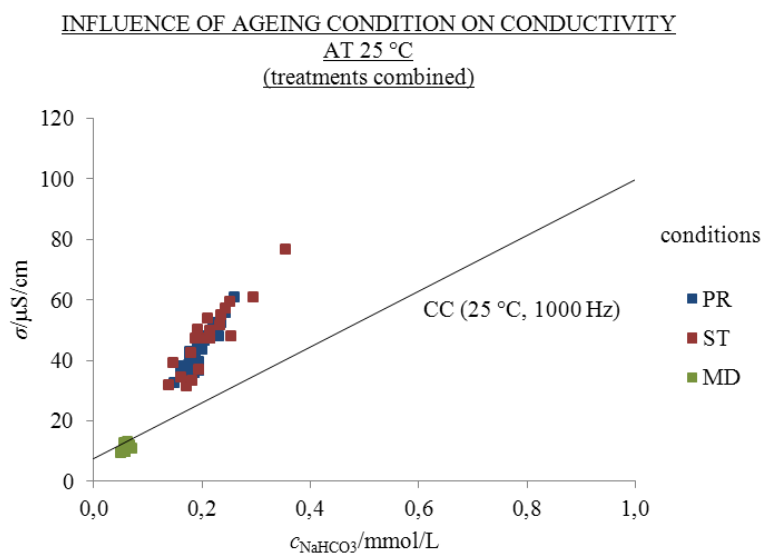
Figure 6. σ at 25 °C and 1000 Hz as a function of c 310 days in 2 mL volume of 2.5 mL flasks under conditions PR (blue), ST (red) and MD (green) aged solutions; points in the graph represent individual measurements; number of replicate solutions, N (/): PR (28), ST (20), MD (20). Treatments are combined; conductivity above the CC line is